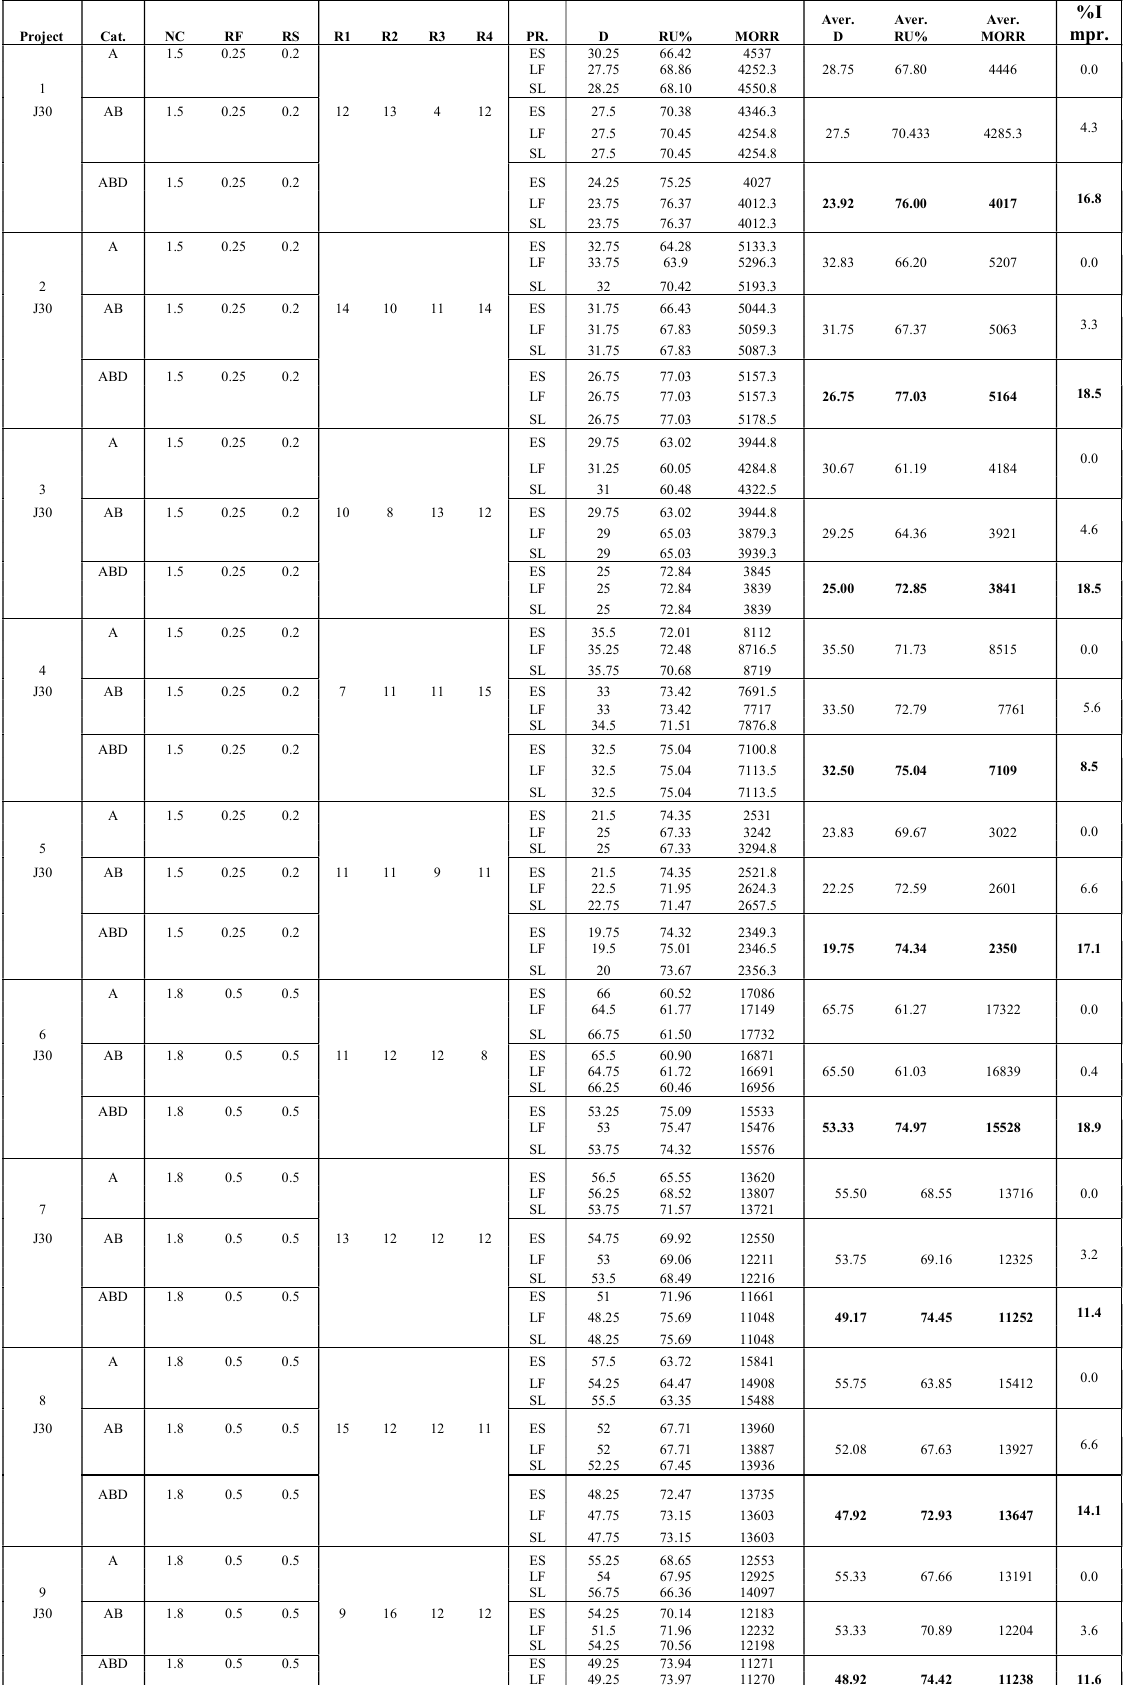
Table A.1 The problem instances used in the paper